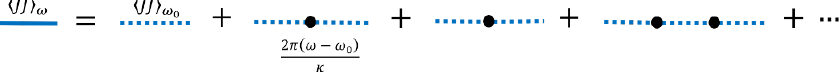
Figure 9. Diagrammatic relation between , solid blue lines to JJ (cid:31) (cid:30) ω 0 symmetry factor). The “chain” ∆ ω 0